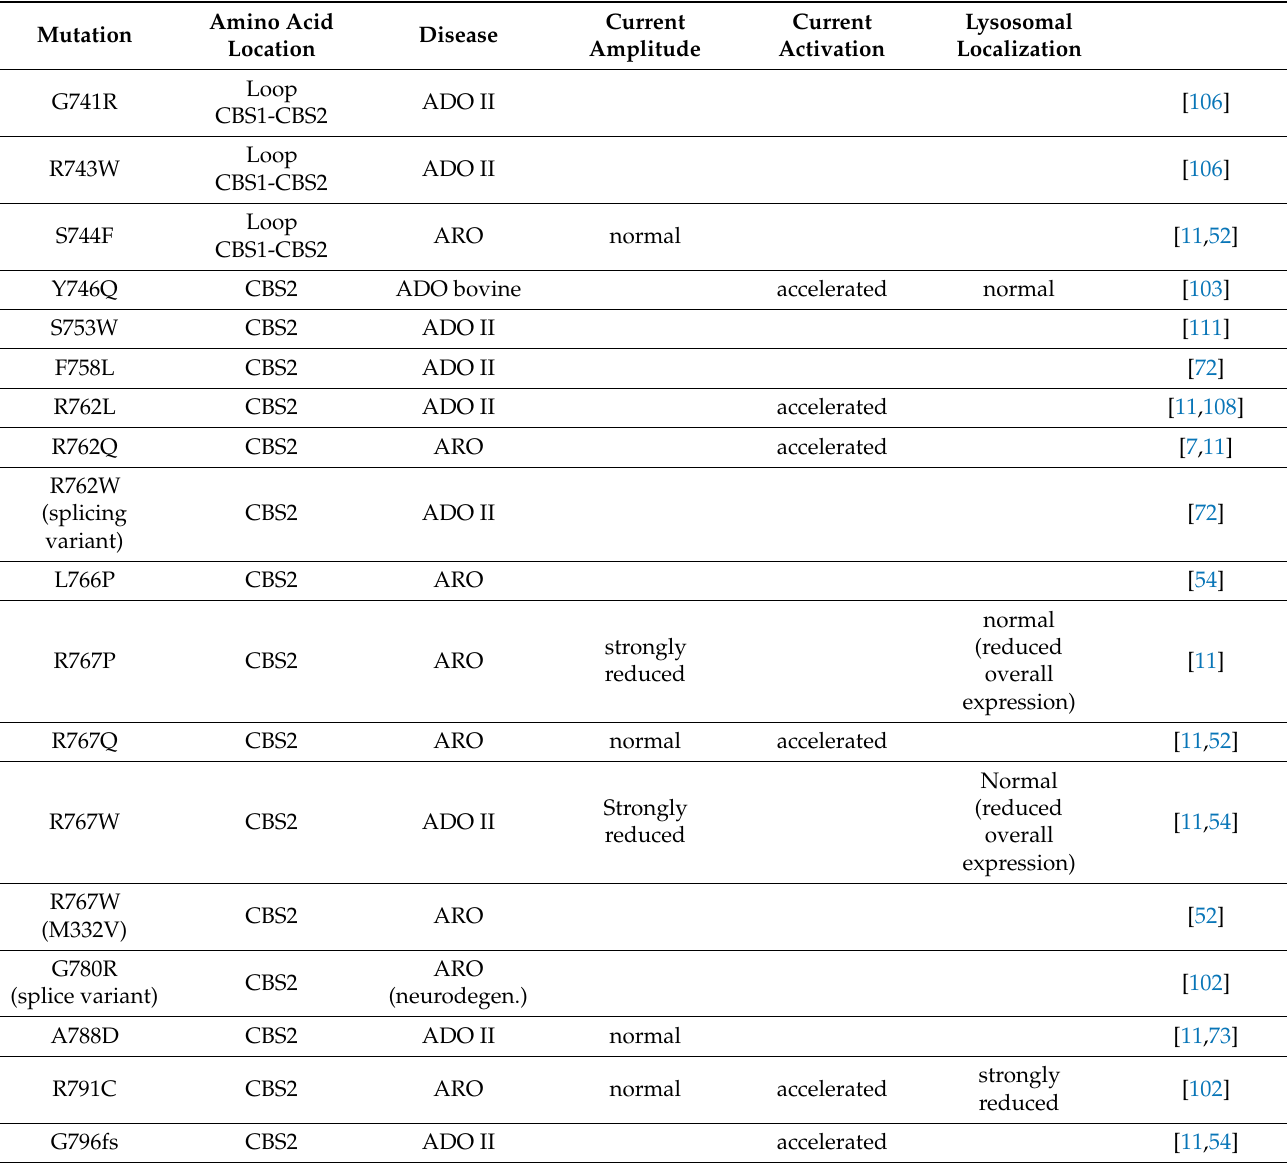
The table indicates the amino acid location, the specific type of osteopetrosis (ARO, ADO II and IARO), the effect of the mutation on the current amplitude and activation kinetics and on the lysosomal localization. Additional residues involved in osteopetrosis and located at the dimer interface are in the CBS1 domains like R674Q, G677V. Other residues in the transmembrane regions